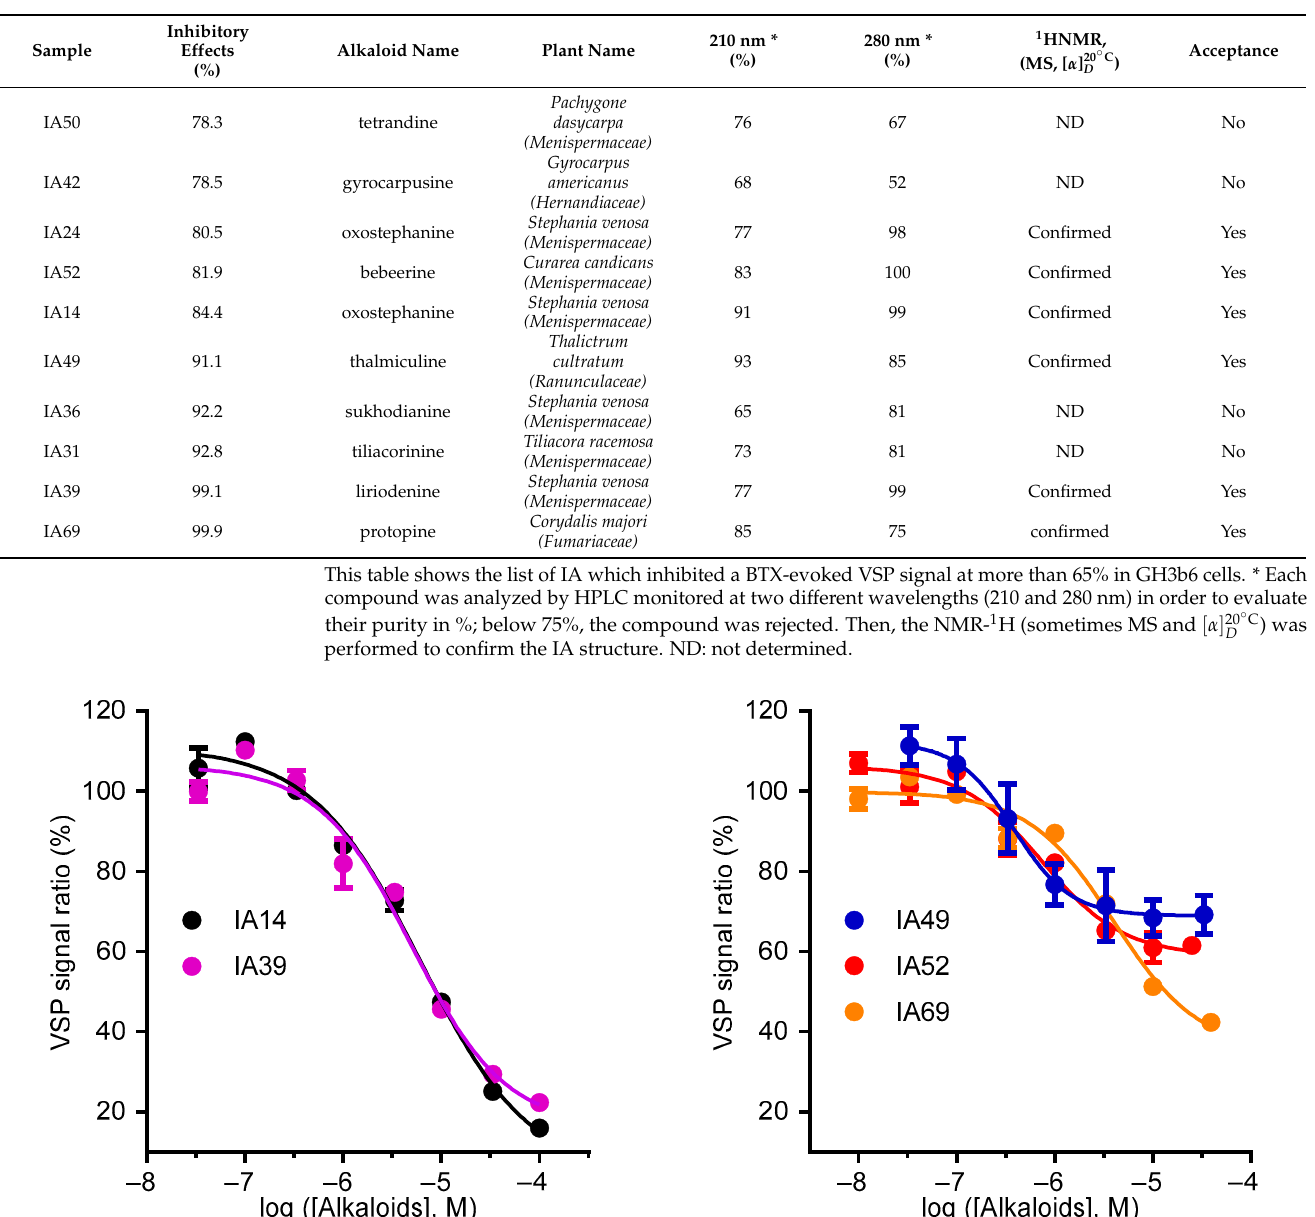
Table 1. Chemical analysis of IA selected for their ability to inhibit a BTX-induced VSP signal.